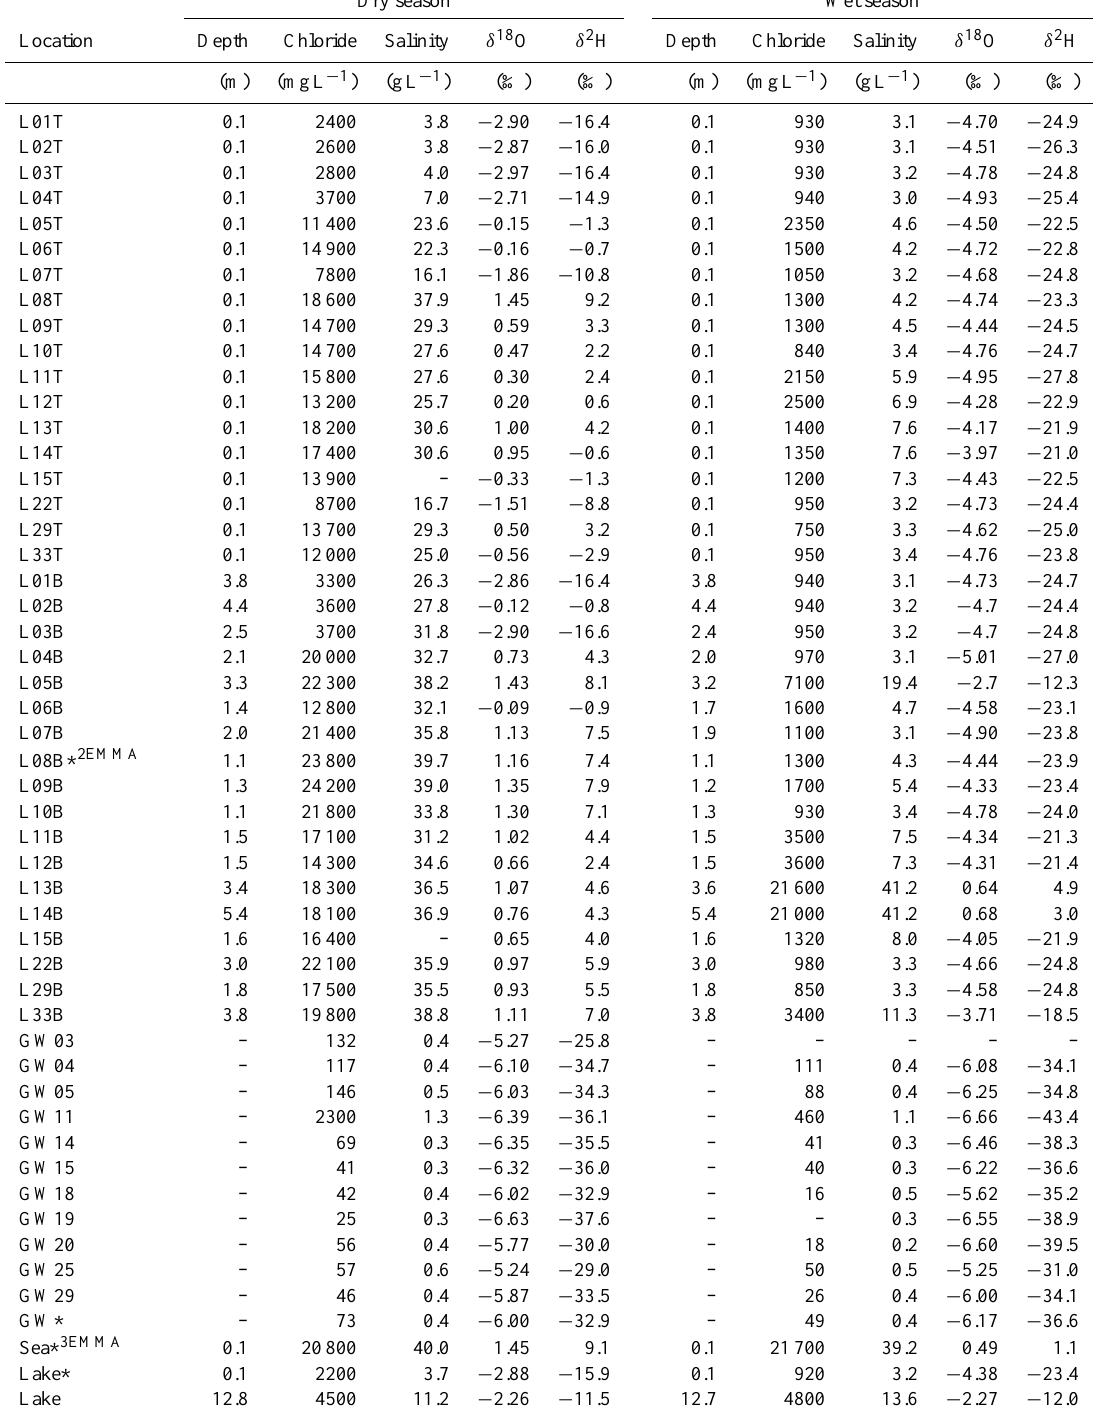
Table 1. Chemical analyses of water samples for the dry and wet seasons; asterisks indicate values used for endmember mixing analysis using either a three (3EMMA) or two (2EMMA) mixing